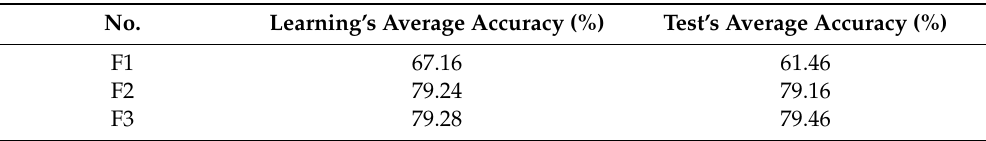
Table 14. Highest accuracy of each problem with the ANE-NNRW.